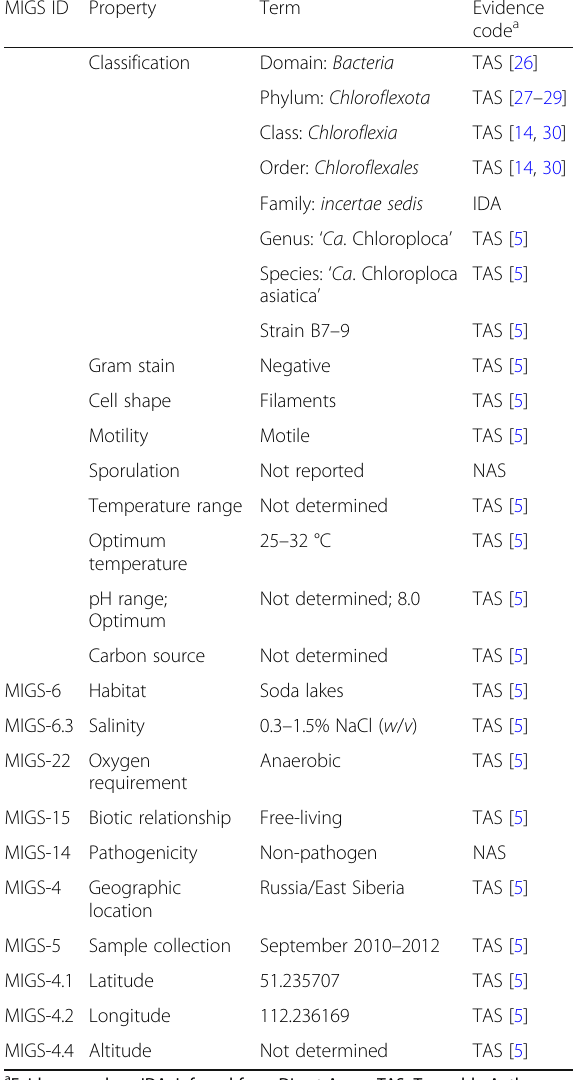
Table 1 Classification and general characteristics of ‘ Ca.